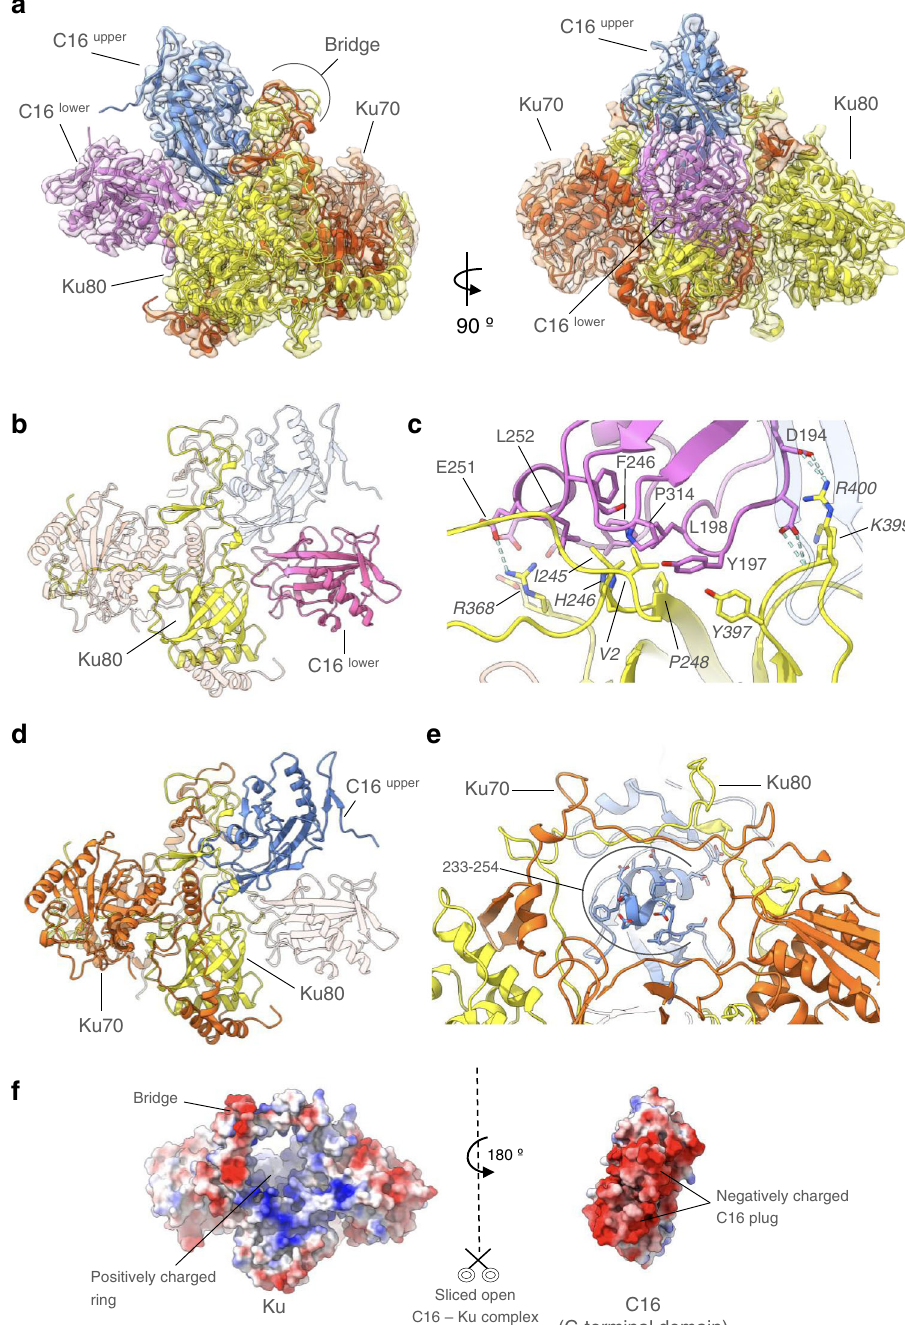
Fig. 4 | Structure of the C16 – Ku complex. a Orthogonal views of the atomic modeloftheC16 – KucomplexintheC16-C – KuexperimentalcryoEMmap.TheC16 dimer binds on one side of the Ku bridge structure, making contact only with the Ku80 subunit. b The lower C16 subunit interacts primarily with the rim of the core β -barrel of Ku80. c Detailsofthe interaction of the lower C16 molecule with Ku80. The core of the interface is provided by packing of hydrophobic side chains of Ku80intoacurvedhydrophobicgrooveonC16,reinforcedbypolarinteractionsat the periphery of the interface. Most of the residues involved from C16 are well